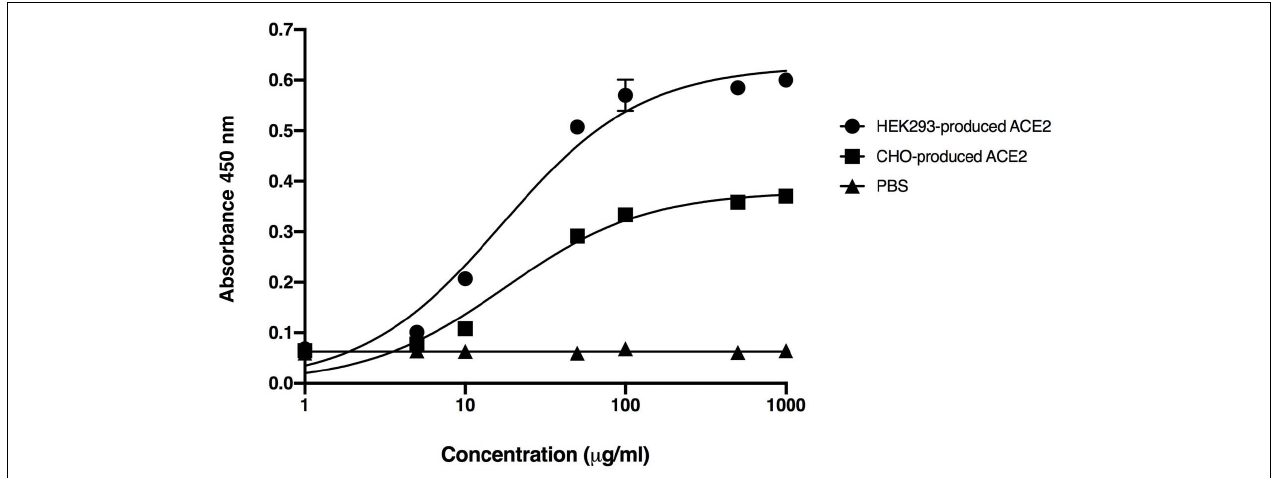
FIGURE 3 | Binding activity of the plant-produced SARS-CoV-2 RBD-Fc with the commercial angiotensin-converting enzyme 2 (ACE2 proteins) derived from HEK293 and CHO cells analyzed by ELISA. PBS was used as negative control. Data are presented as mean ± standard deviation (SD) of triplicates in each sample